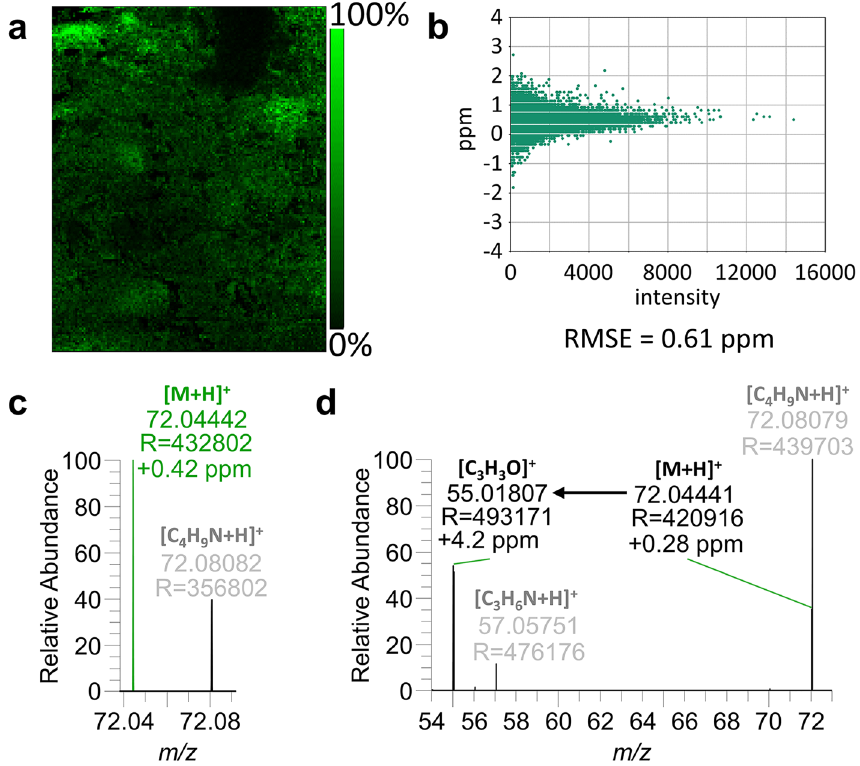
Figure 3. MS imaging of acrylamide in German gingerbread. ( a ) MS image of acrylamide [M + H] + , m/z 72.04439, TIC-normalized. ( b ) Mass measurement accuracy plot and RMSE value for the acrylamide signal. ( c ) single pixel mass spectrum of acrylamide ( d ) in-situ MALDI-MS/MS spectrum showing the characteristic fragment at m/z 55.01784, isolation window: m/z 72.0 ± 0.2, scan range: m/z 50–80, HCD: 60.